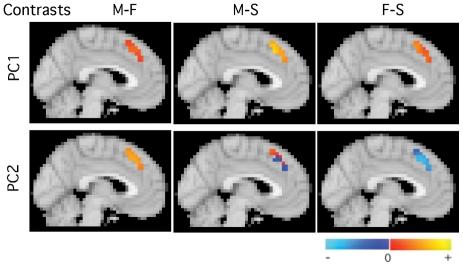
Two PC Solution.The two-PC solution across three contrast images. The ROI consists of a single cluster in the left anterior paracingulate gyrus.